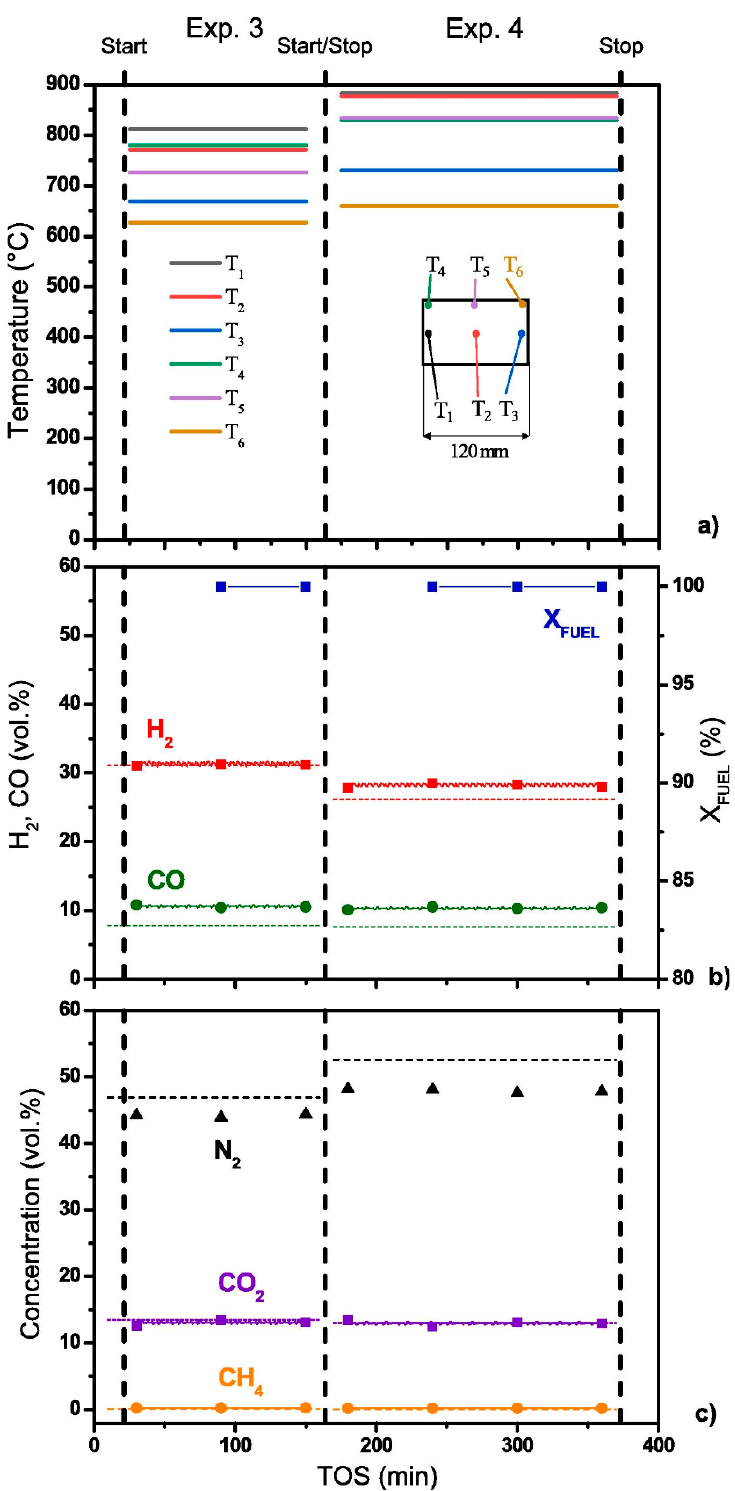
Figure 19. The temperatures in six points of Rh/CZ-42-120 catalytic block ( a ), diesel conversion, H 2 and CO ( b ), N 2 , CO 2 and CH 4 concentrations (dry basis) ( c ) as a function of time on stream during DF ATR experiments. Points and solid lines—experimental data, dashed lines—equilibrium concentrations. Experimental conditions: O 2 :C = 0.6; GHSV = 6750 h − 1 ; O 2 :C = 0.7, GHSV = 7500 h − 1 [91].